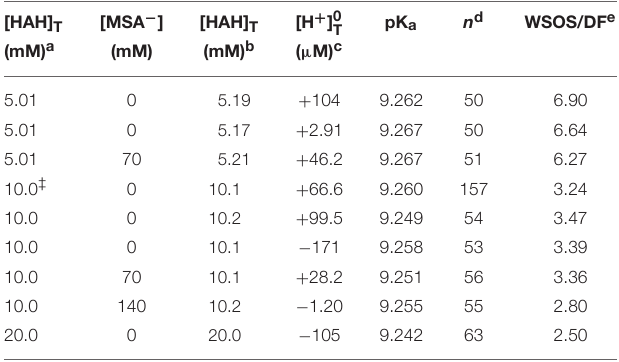
TABLE 3 | Thirteen titrations (pH 3–10) of magnesium in 0.7M NaClO 4 solutions containing 5 or 10 mM acetohydroxamic acid (HAH), some in the presence of 140mM mesylate (MSA −